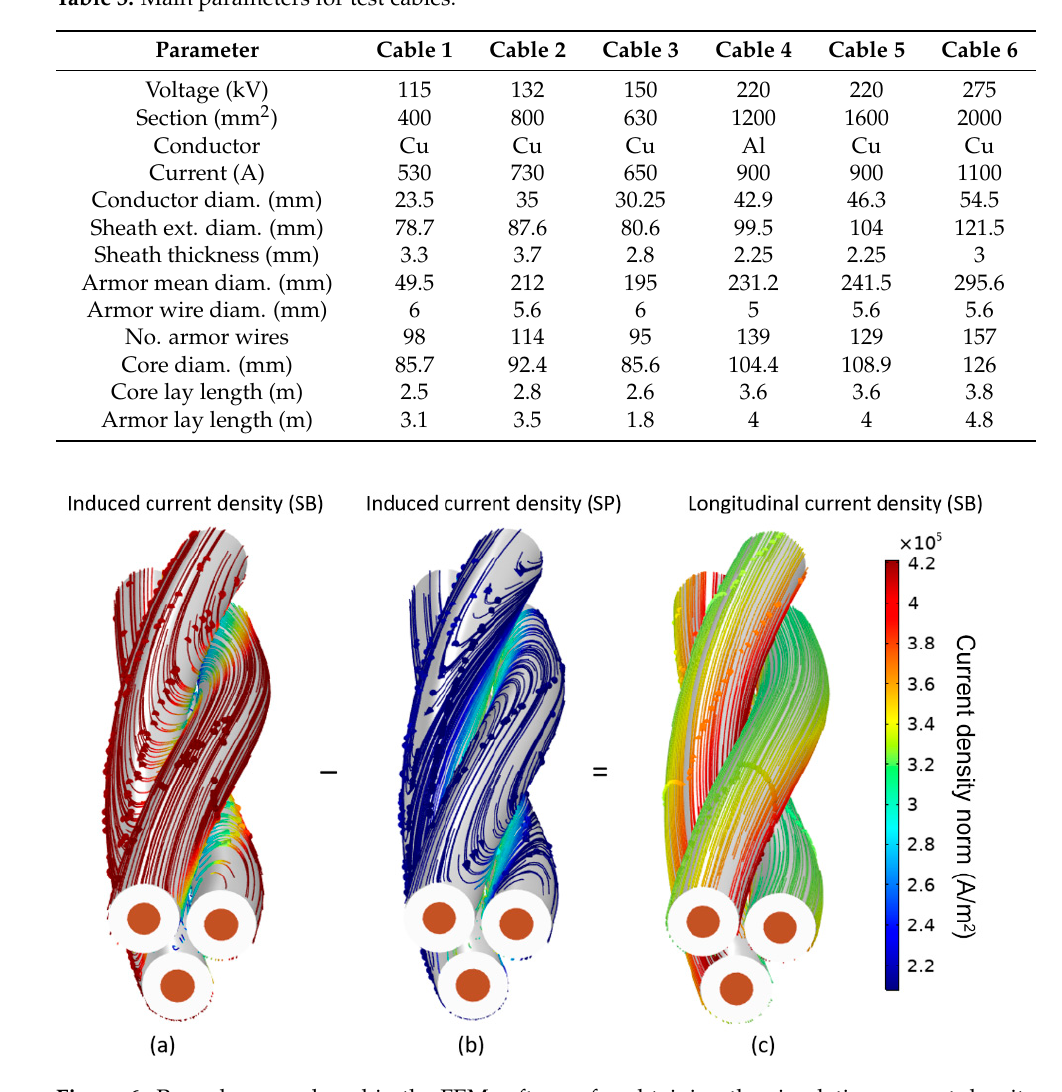
Figure 6. Procedure employed in the FEM software for obtaining the circulating current density ( c ) by subtracting the SP eddy-current ( b ) from the total SB induced current ( a ) (2000 mm 2 , 275 kV unarmored cable, phase current 1100 A).